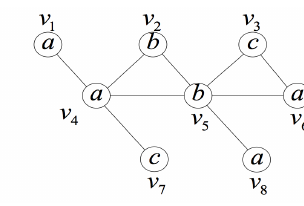
Figure 8. An example of the matched vertices-based pruning